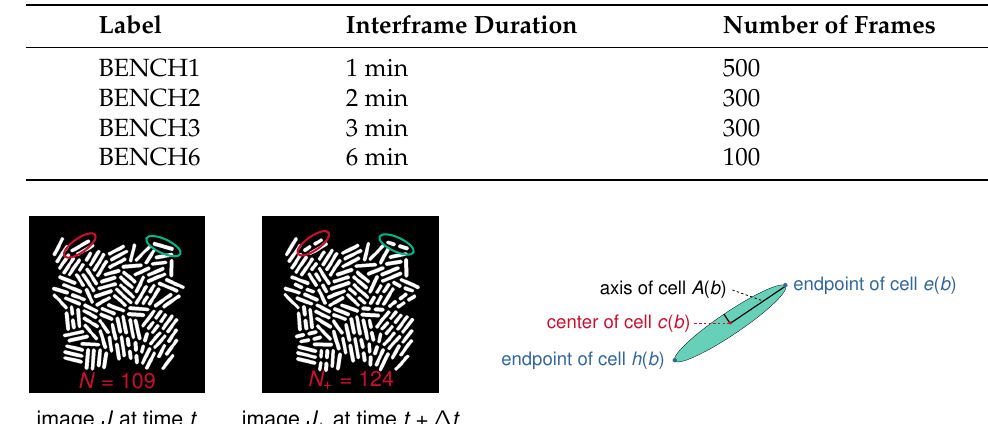
Figure 2. Simulated data and cell characteristics considered in the proposed algorithm. ( Left ): Two successive images generated by dynamic simulation for a colony of rod-shaped bacteria. The left image J displays N = 109 cells at time t . At time t + ∆ t with ∆ t = 1min, cells have moved and grown, and some have divided. These cells are displayed in image J + , which contains N + = 124 cells. We highlight two cells that have undergone a division between the frames (red and green ellipses). ( Right ): Geometry of a rod shaped bacterium. We consider different quantities of interest in the proposed algorithm. These include the center c ( b ) of a cell, the two end points e ( b ) and h ( b ) , and the long axis A ( b ) ,